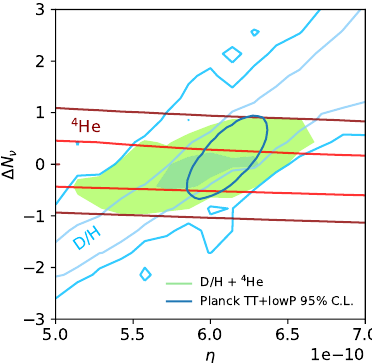
Figure 4. Constraints in the η − ∆ N ν plane (68% and 98% C.L.) from observations of D / H (light blue lines, from [9]), 4 He (red lines, from [43]), and combined (green shade). We also show the 95% contours for the Planck Surveyor for comparison (dark blue, from TT + LowP in